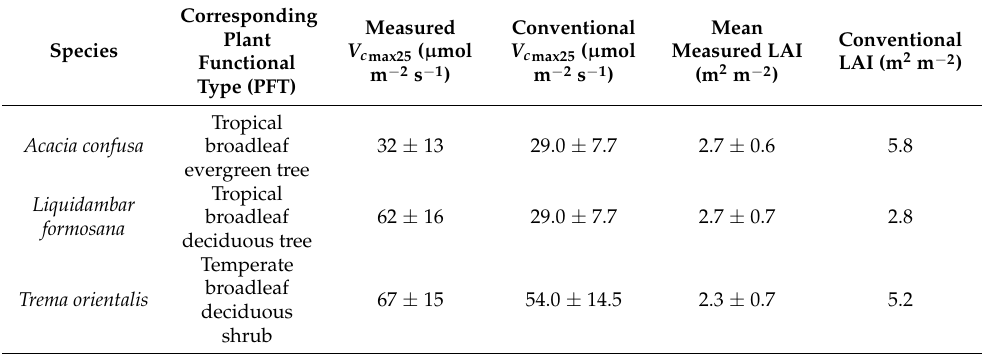
Table 2. Maximum carboxylation rate at 25 ◦ C ( V c max25 ) and leaf area index (LAI) data obtained from measurements using LICOR-6800 and LICOR-2200C in Tai Tong, Hong Kong and literature. Uncertainties are represented by ± 1 standard deviation. Conventional values for corresponding plant function types (PFTs) of the respective species are given by Kattge, Knorr, Raddatz and Wirth [16] and Oleson et al. [26]. The LICOR-6800 photosynthesis system measures real-time foliage physiological parameters and photosynthesis rate by an infrared gas analyzer and quantifies important parameters of light reaction, chlorophyll and gaseous exchange by a fluorometer. The LAI meter LICOR-2200C has an optical sensor that measures foliage density by considering the proportion of sunlight blocked by the plant canopy.